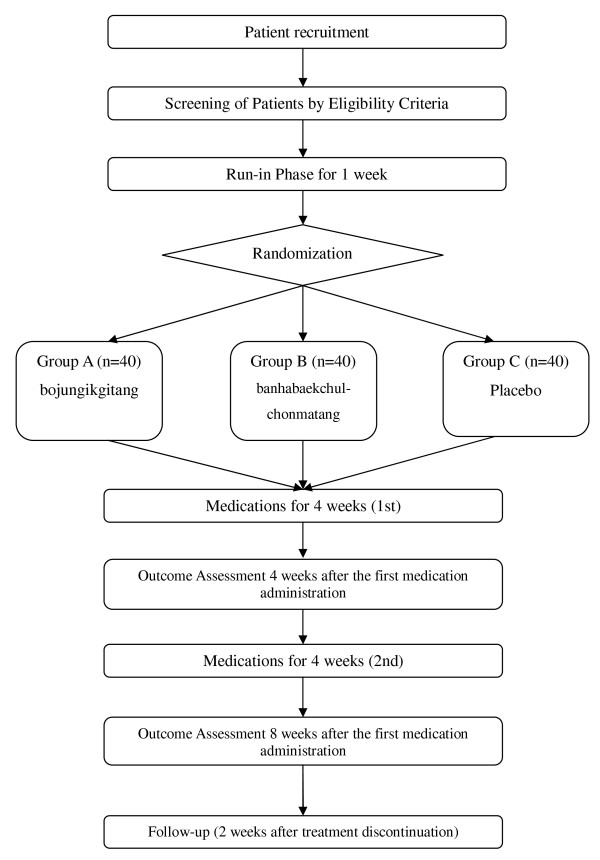
Study Flow Chart.